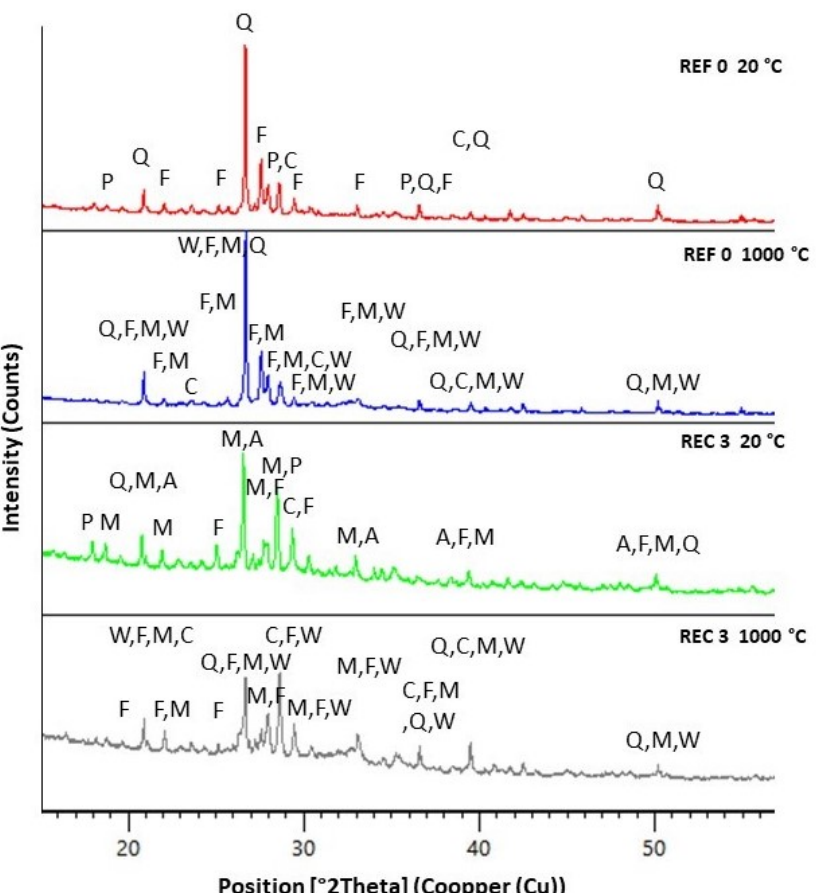
Figure 9. XRD results of LWC at 20 and 1000 °C ( A —Aragonite, C —Calcite, F—Feldspar, Q —Quartz, M —Mica, P —Portlandite, W —Wollastonite).